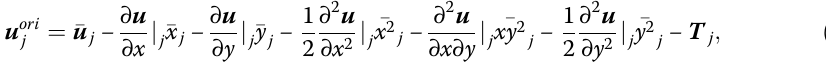
gauss points to guarantee the flux integration is higher-order accurate. The